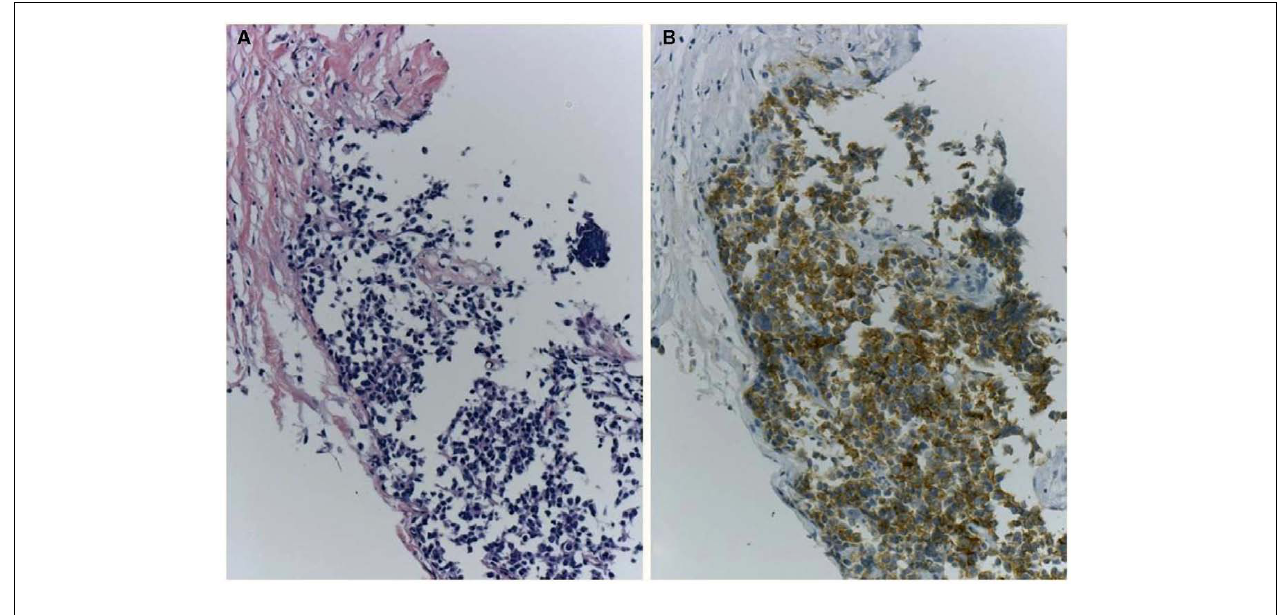
reports of SCLC with ALK fusion, the tumor cells were positive for ALK immunohistochemistry using clone 5A4 and Envision FLEX + (B) . No gene rearrangement and chimeric transcript of EML4–ALK have been detected, respectively.